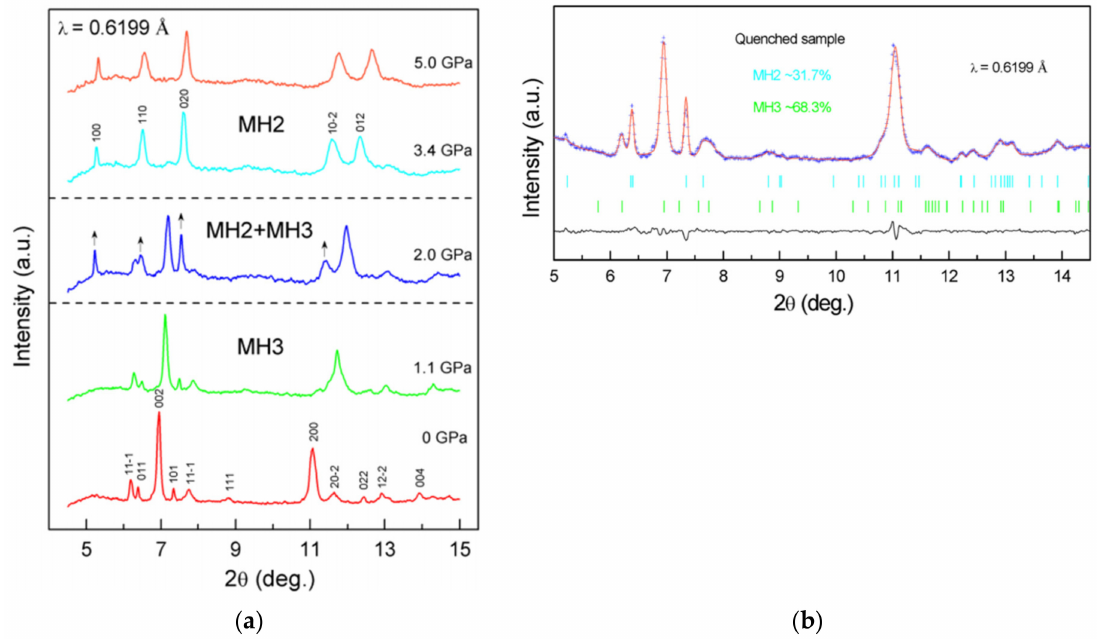
Figure 5. ( a ) Representative ADXRD patterns at elevated pressures. Arrows indicate new peaks. ( b ) Quantitative phase analysis based on the Rietveld fit of the diffraction patterns collected from the quenched sample: red line, experimental pattern; blue dotted line, simulated pattern; the black line is the fit residual. Reprinted with permission from Ref. [78]. Copyright 2014 American Chemical